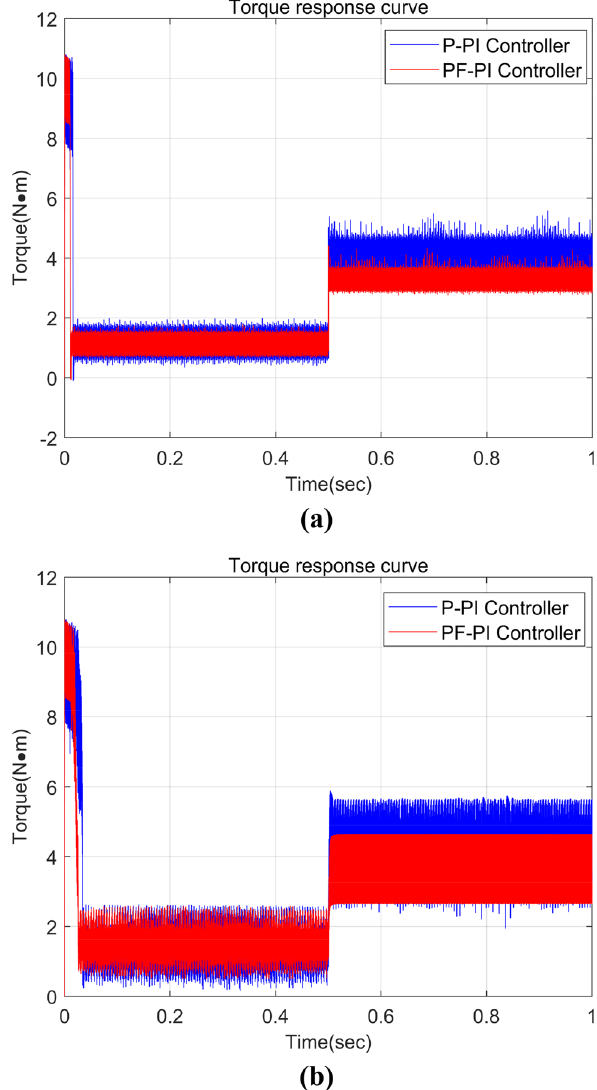
Fig. 18 Torque ripple curves of sudden addition disturbance load start under different conditions a 0–1500 rpm and b 0–3000